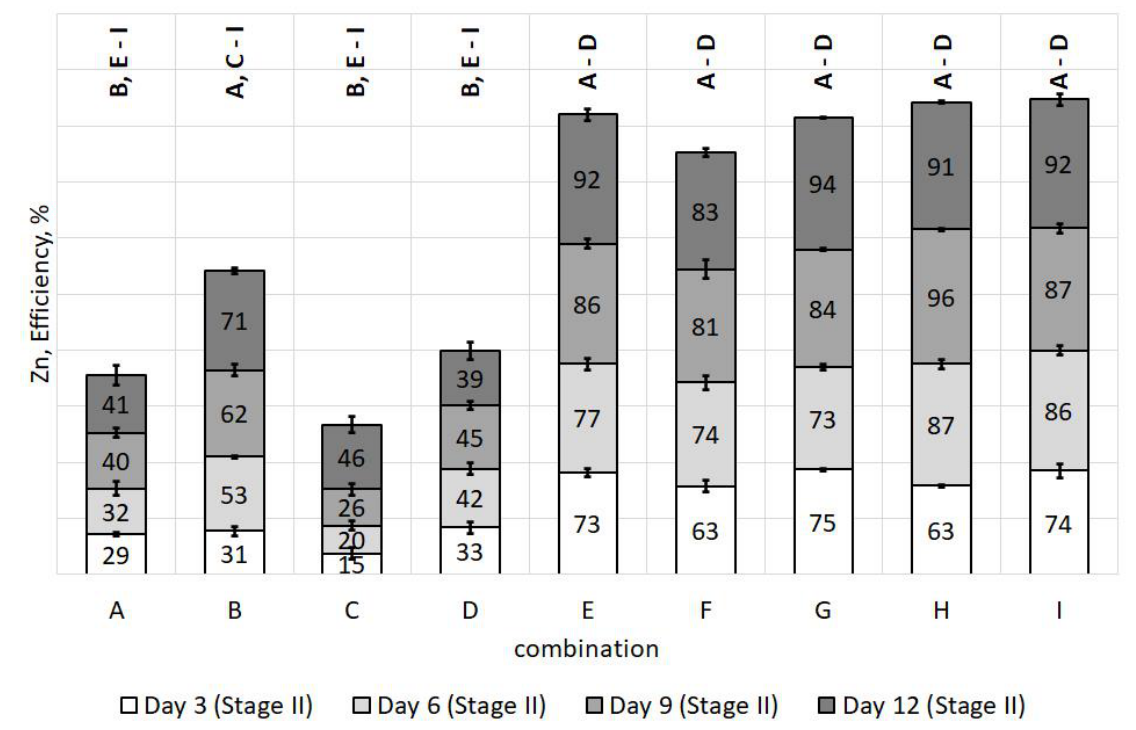
Figure 20. Effectiveness of Zn release to the dissolved fraction of leachate (Stage II).